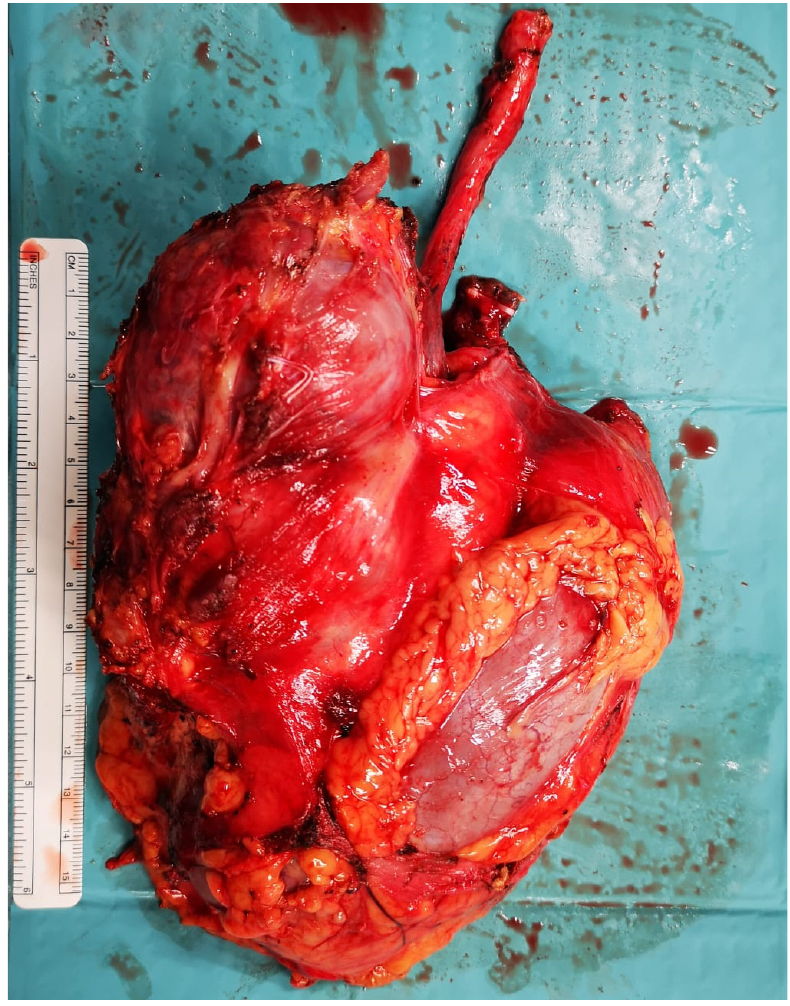
Figure 5. Radical nephrectomy during retroperitoneal lymph node